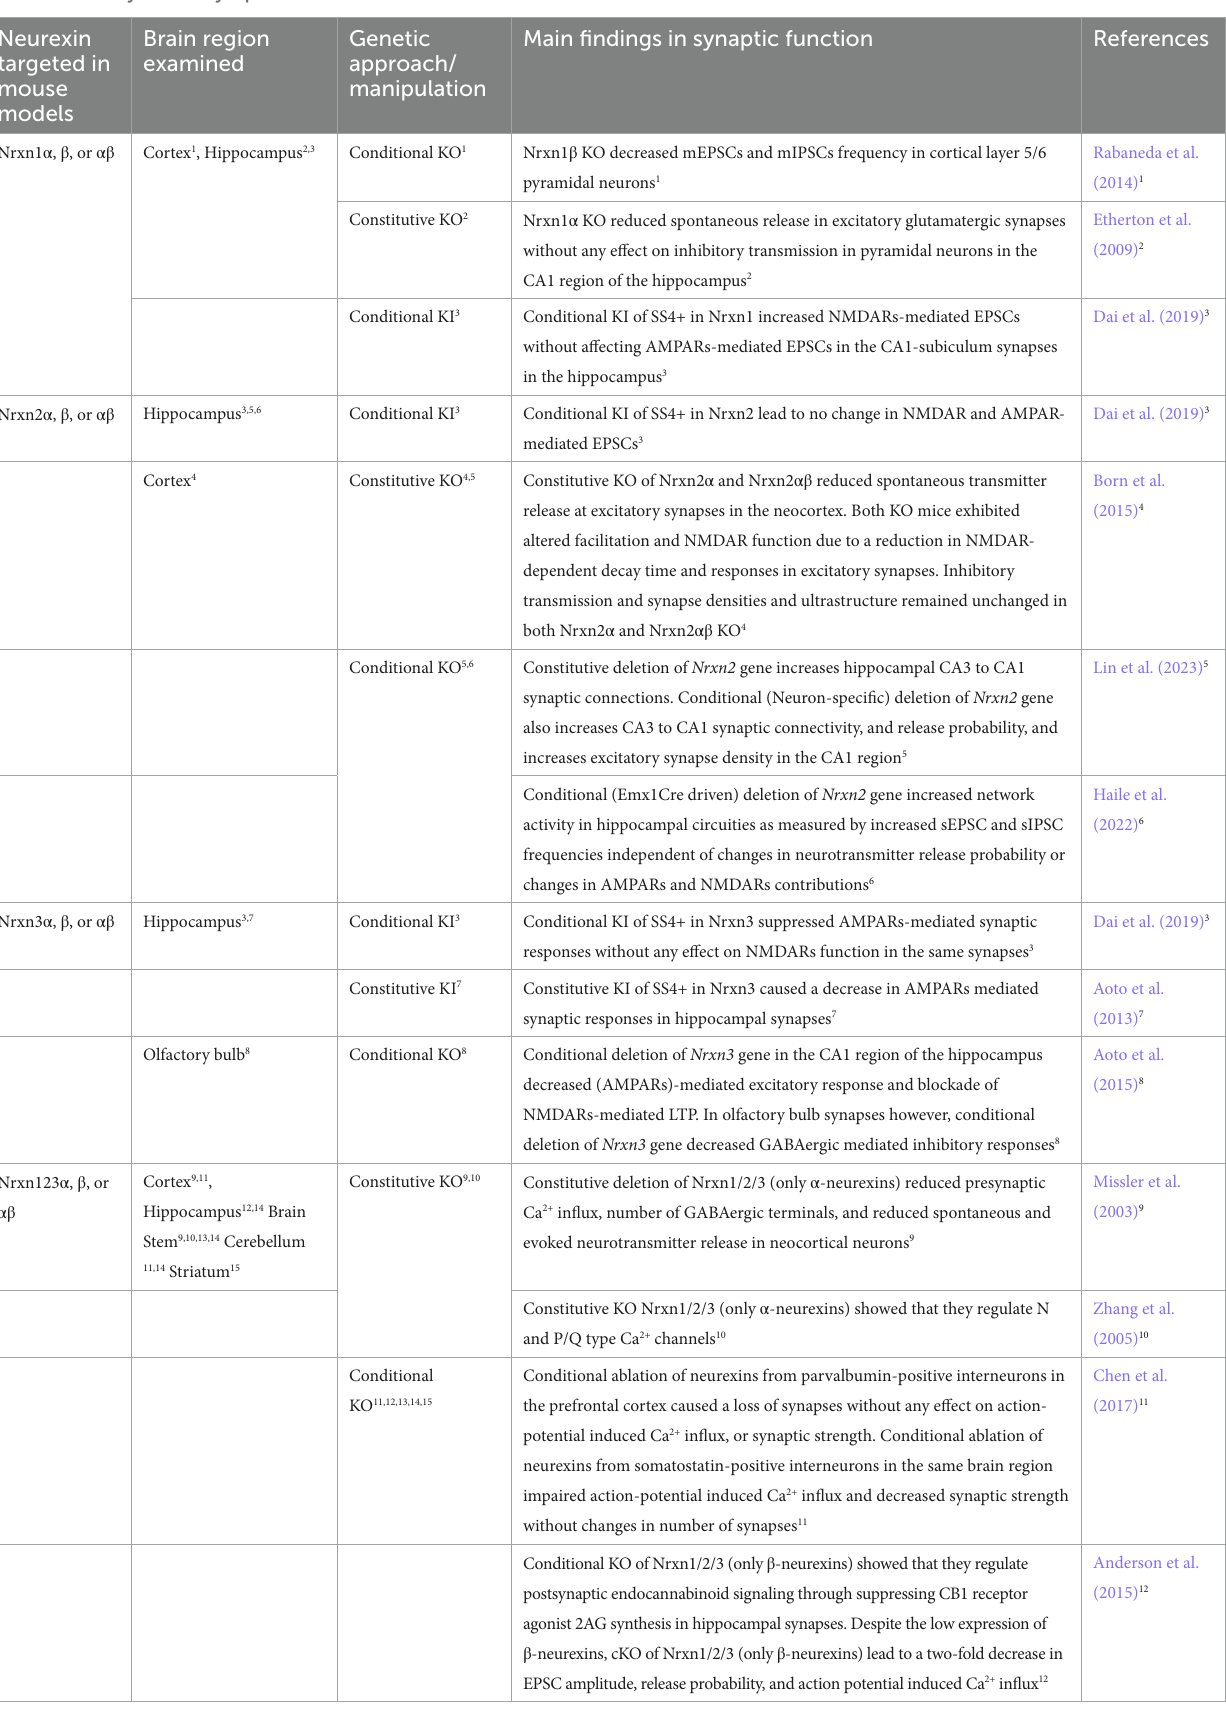
TABLE 1 Summary table of synaptic transmission examined in neurexin mutant mouse models. Neurexin targeted in mouse